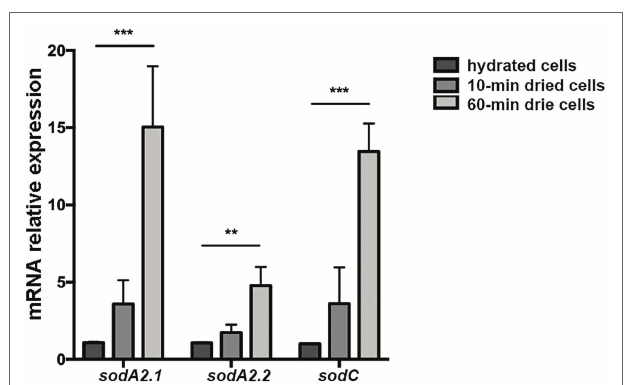
FIGURE 7 | Expression of SOD-coding genes of Chroococcidiopsis CCMEE 029 in response to desiccation. The sodA2.1 and sodA2.2 genes encode two MnSODs and sodC gene encodes a CuZnSOD. Expression levels are shown as a ratio between the target gene and the 16S rRNA gene. Control: hydrated cells. Data represent mean ± SD ( n ≥ 3), *** p < 0.001 and ** p < 0.01.